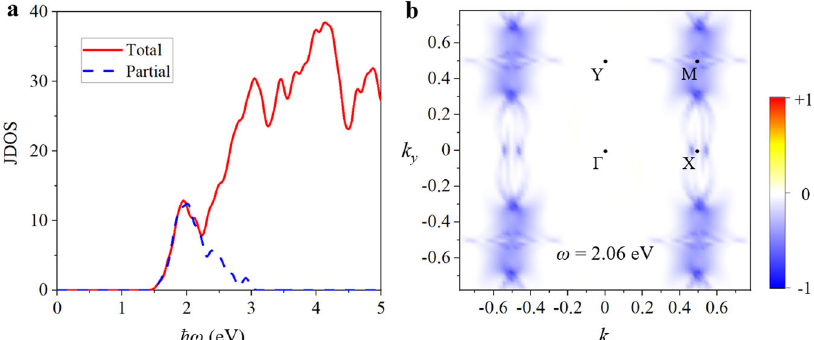
Fig. 6 Analysis of BPVE response. a Total JDOS (red solid line) of penta-PdSSe. The blue dashed line shows the contribution from the couplings between upmost four valence bands and lowest four conductions bands. b k -resolved shift current for the transition with photon energy of 2.06 eV in